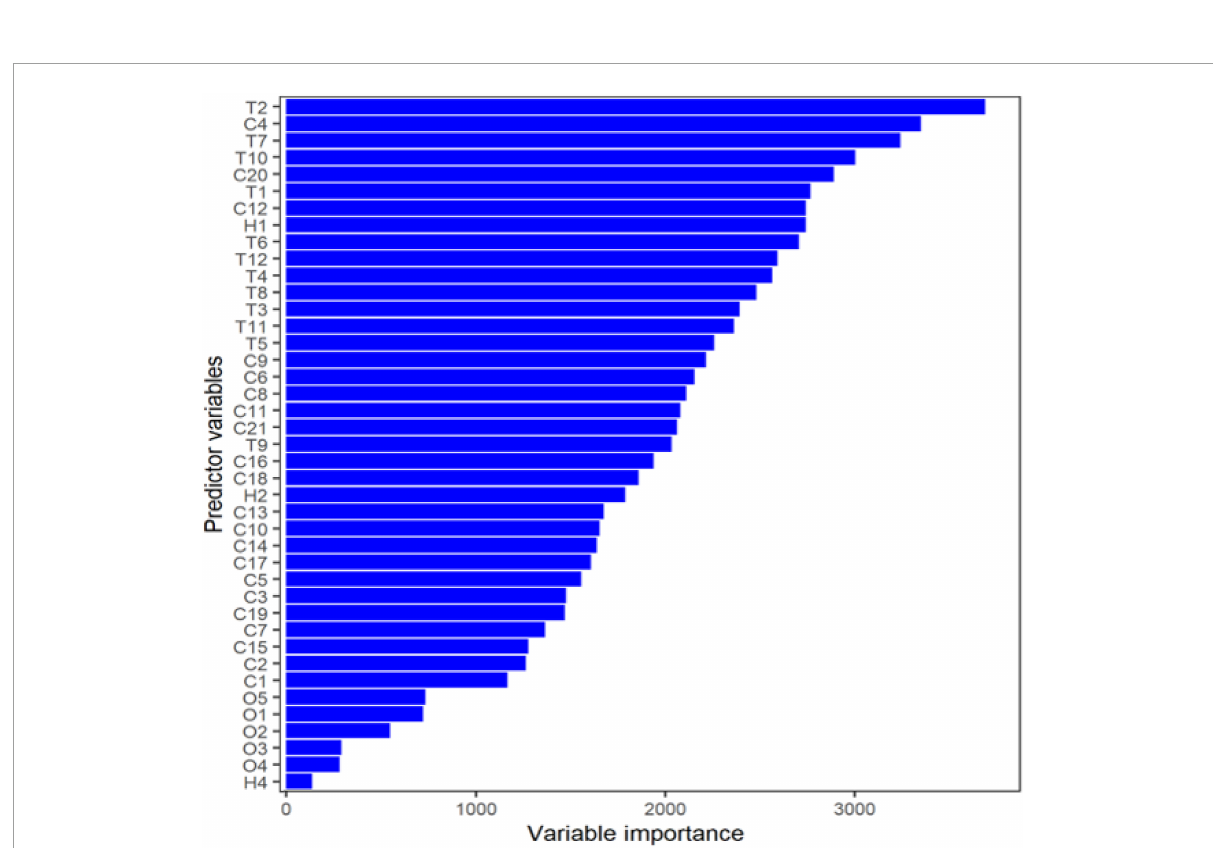
FIGURE2 Variable importance of the predictor of the basal area in black walnut based on the Gini model (IncNodePurity: variables that split at each node) using random forests machine learning The value was calculated based on the Gini model for each of the 42 independent variables. See Table 1 for definitions of each predictor